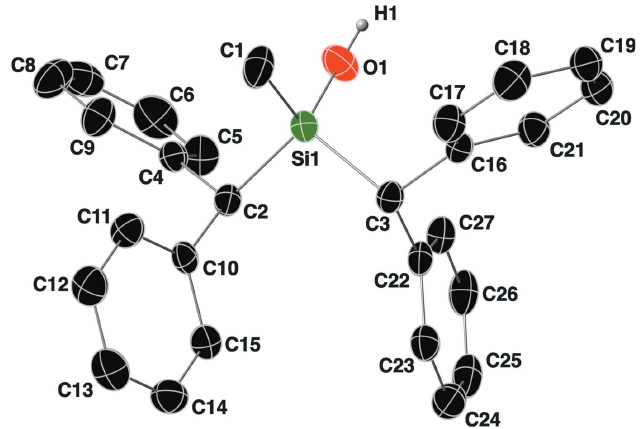
Figure 3 The molecular structure of compound II , with the atom-labeling